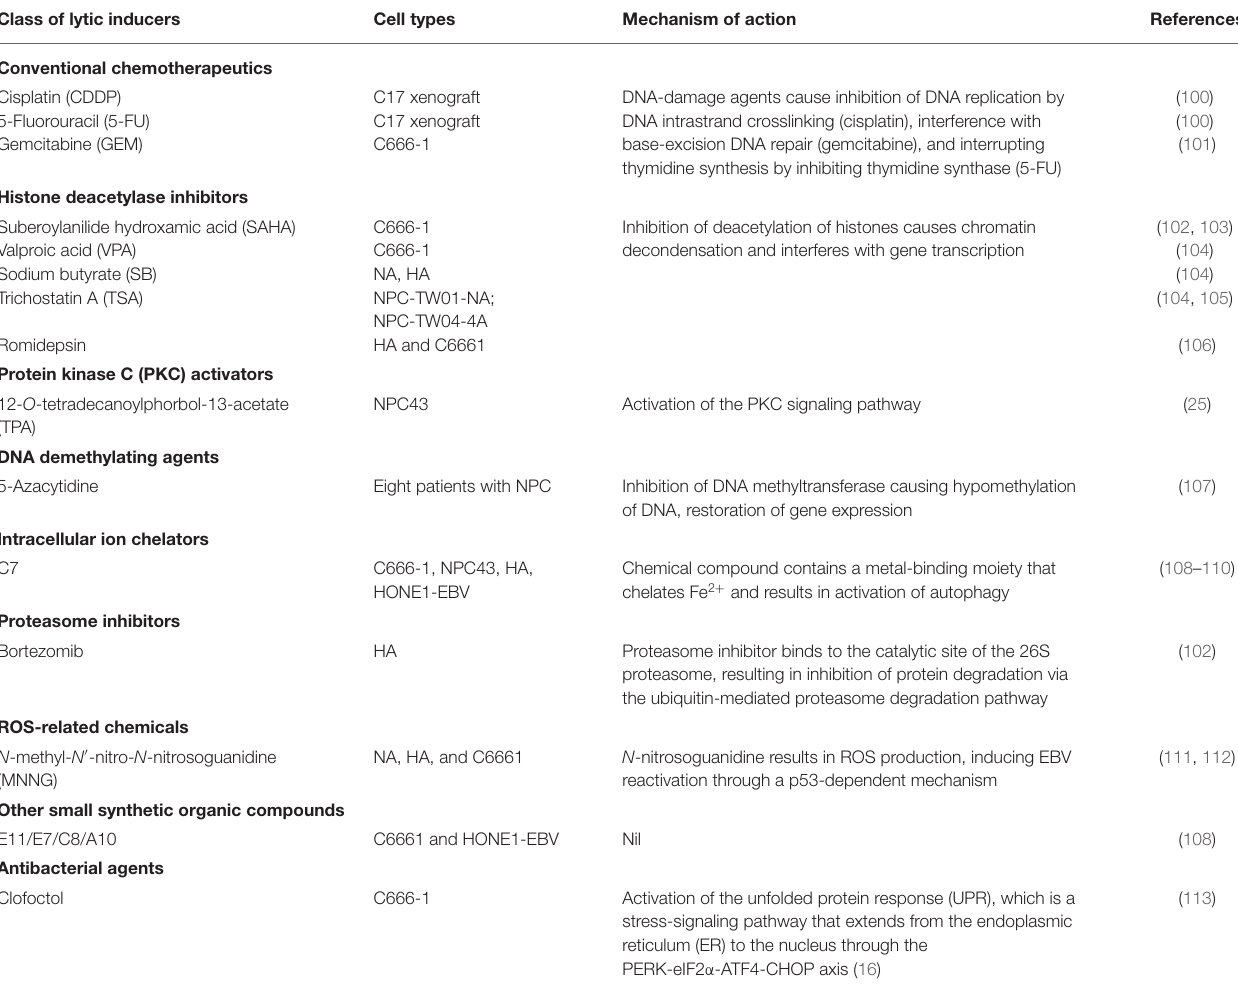
TABLE 2 | Chemical agents that reactivate the Epstein-Barr virus (EBV) lytic cycle in nasopharyngeal carcinoma (NPC). Class of lytic